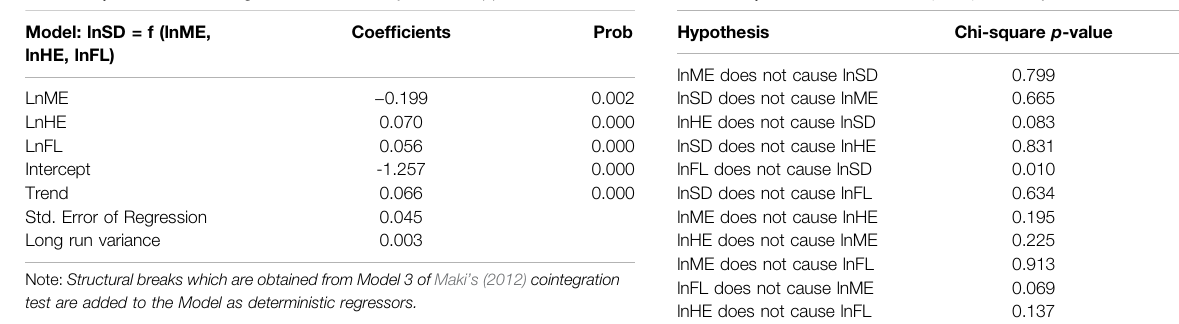
TABLE 9 | Toda and Yamamoto (1995) Causality test